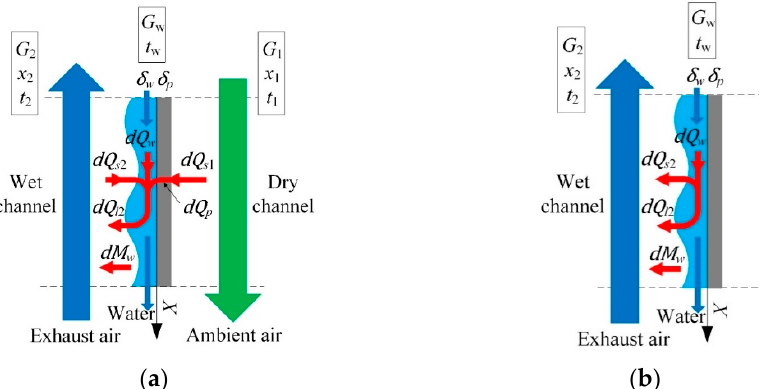
Figure 2. Schematic of the mathematical processes of MCTs: ( a ) the wet channel being equal to the dry channel; ( b ) the wet channel being longer than the dry channel.